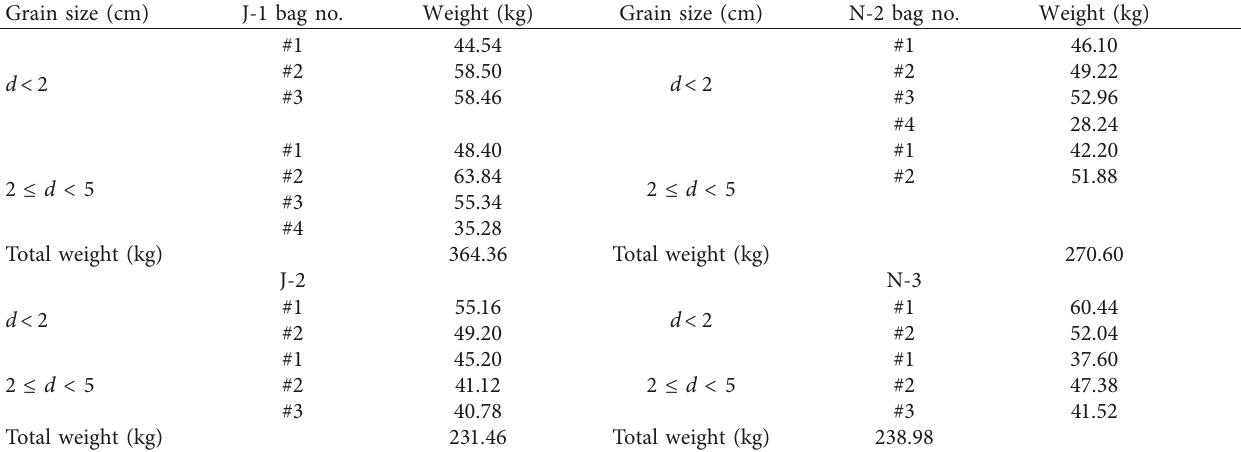
Table 2: Sampling and weight.